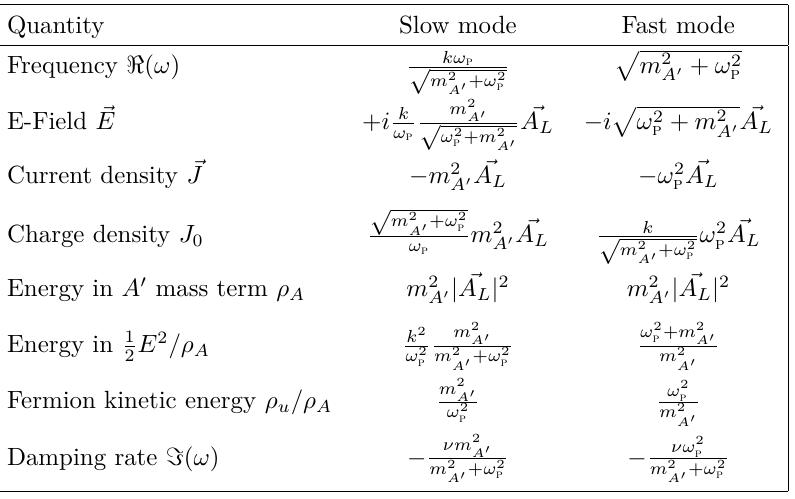
Table 1. Summary table for the long-wavelength ( k (cid:28) max ( m A 0 , ω p ) ) “slow” and “fast” longitu- dinal modes of a Proca plasma in the cold fluid approximation in Minkowski space. These results are only valid for collision rates ν . ω p . In our case, when plasma effects are important, the modes of A 0 produced by inflation have a behavior (in curved space) that is quite analogous to the slow mode discussed